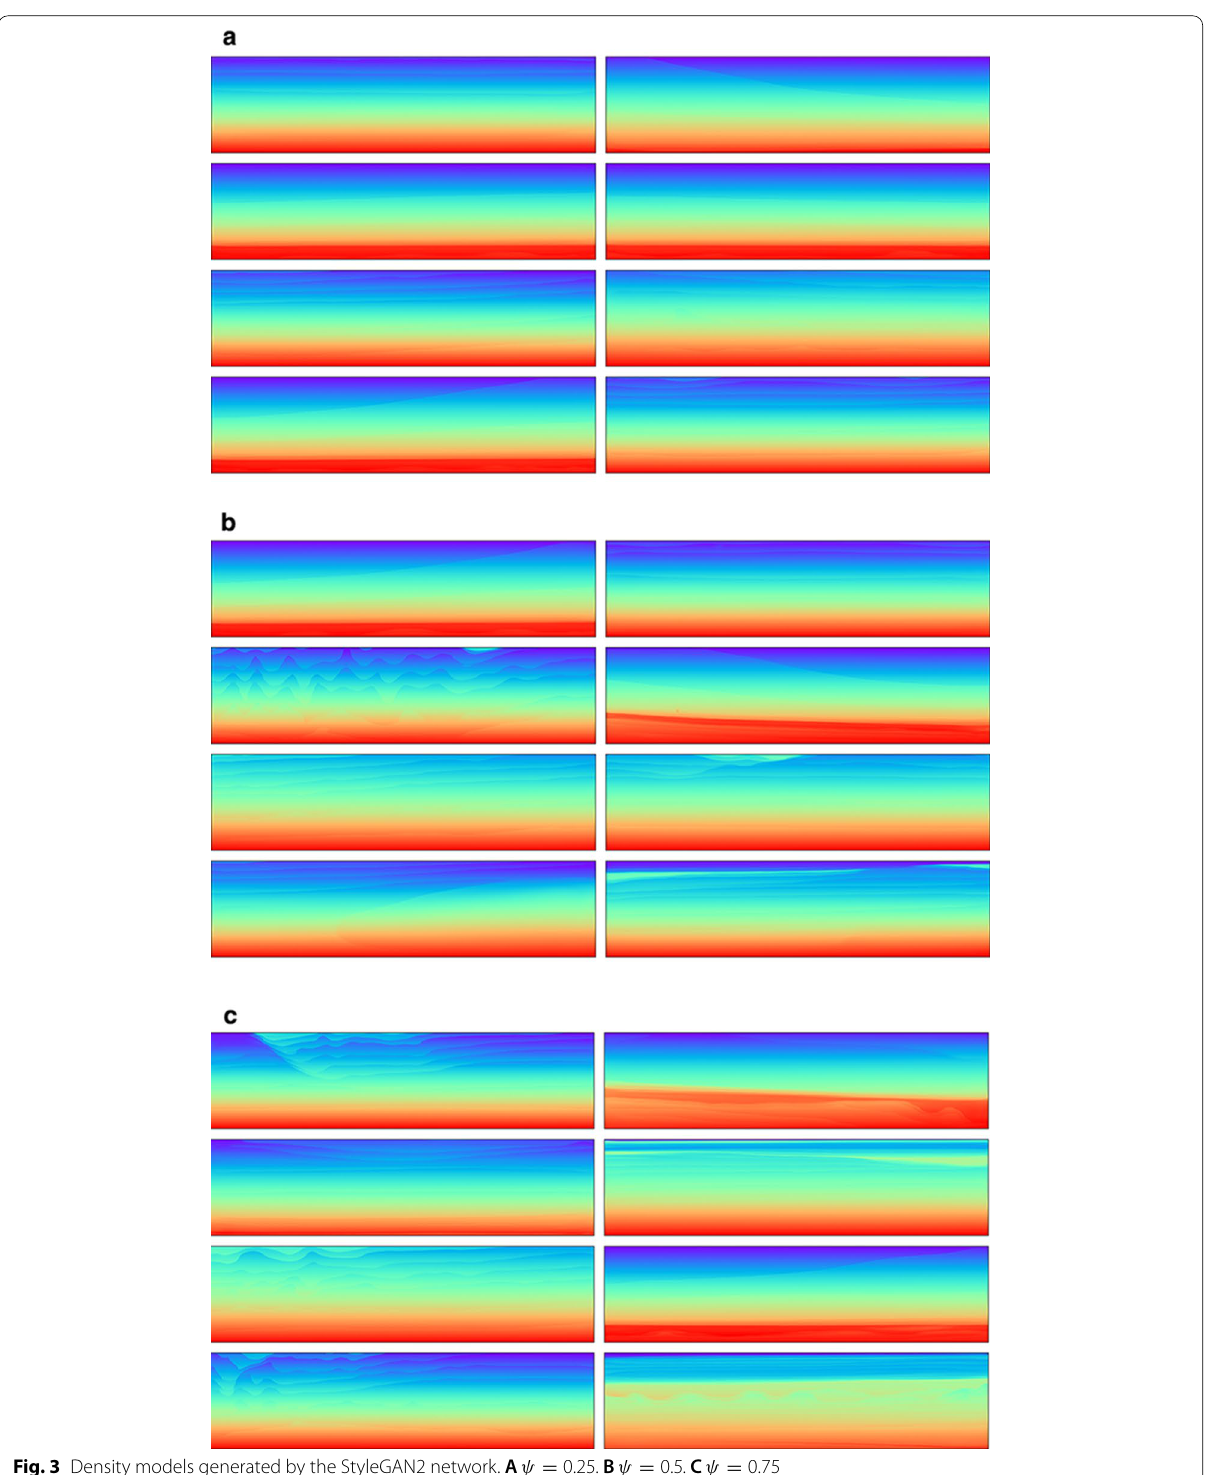
Fig. 3 Density models generated by the StyleGAN2 network. A ψ = 0.25 . B ψ = 0.5 . C ψ =